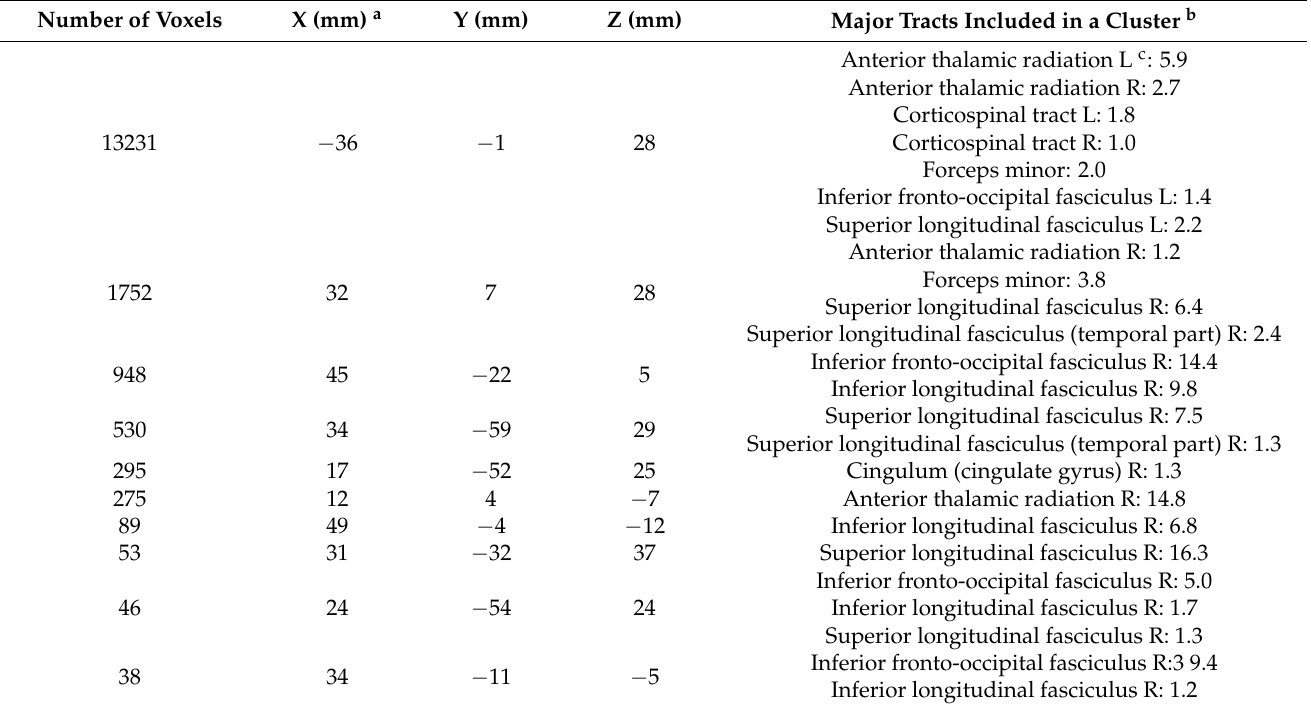
Table 2. Localization and size of significantly different clusters between AVH+ and AVH- participants. The numbers after each tract label indicates the percentage probability of the cluster to belong to the given (John Hopkins University) JHU white matter tractography atlas